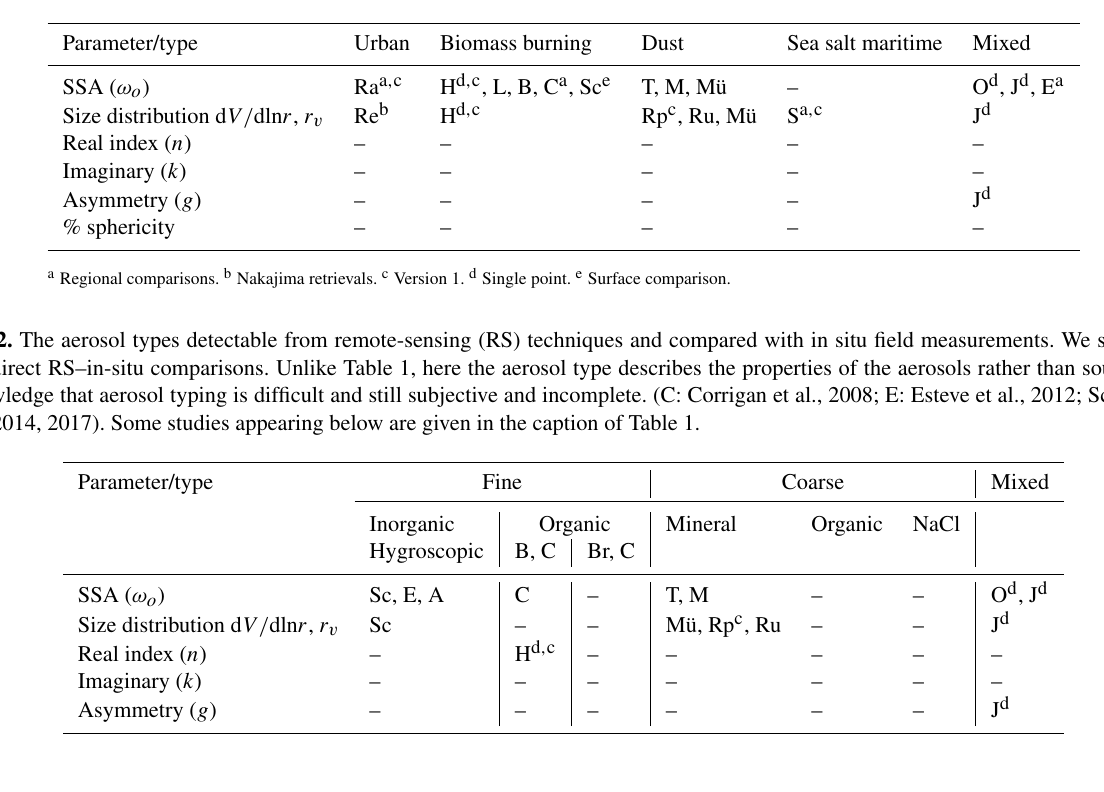
Table 1. Principle intensive parameters retrieved by sun and sky scanning spectral radiometers for five aerosol types. Sixteen published validations/comparisons of these retrievals against in situ measurements were made during field campaigns prior to 2010. Ra: Ramanathan et al. (2001); Re: Remer et al. (1997); H: Haywood et al. (2003); L: Leahy et al. (2007); B: Bergstrom et al. (2003); Chand et al. (2006); E: Eck et al. (2010); M: Müller et al. (2010); Mü: Müller et al. (2012); Rp: Reid et al. (2003); Ru: Reid et al. (2008b); S: Smirnov et al. (2003); Sc: Schafer et al. (2008); T: Toledano et al. (2011); O: Osborne et al. (2008); and J: Johnson et al. (2009). Note that most categories are incomplete (–), are not updated for the current inversion algorithm, and/or not relevant to total-column ambient retrievals.